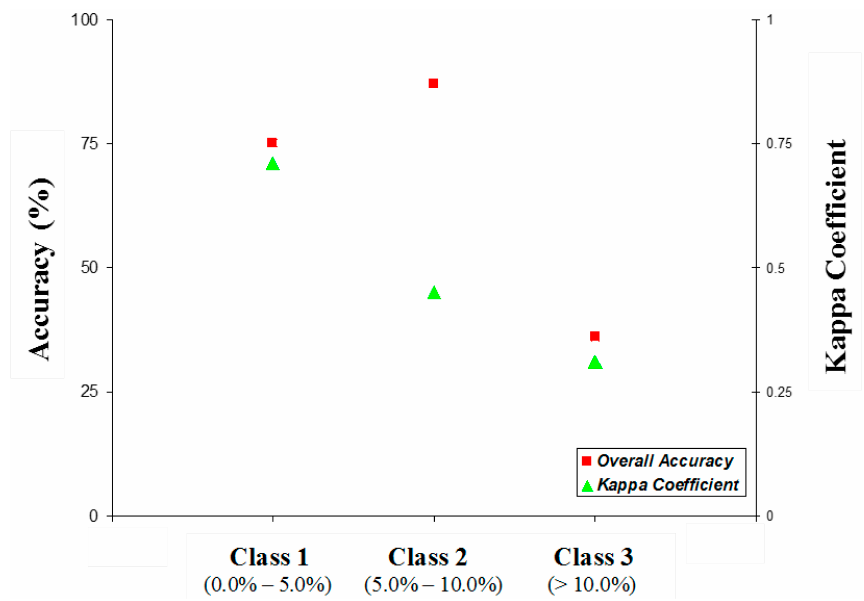
Figure 13. Kappa statistics for 2 August 2006 data set.